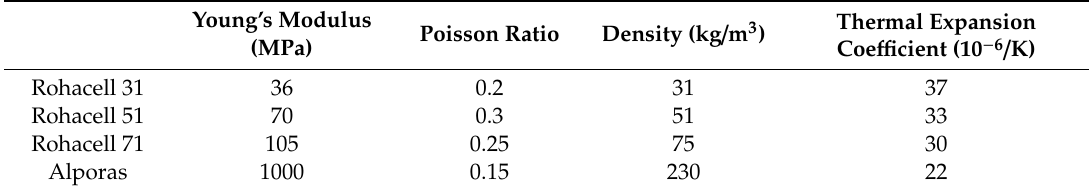
Table 1. Material properties of foam [19].